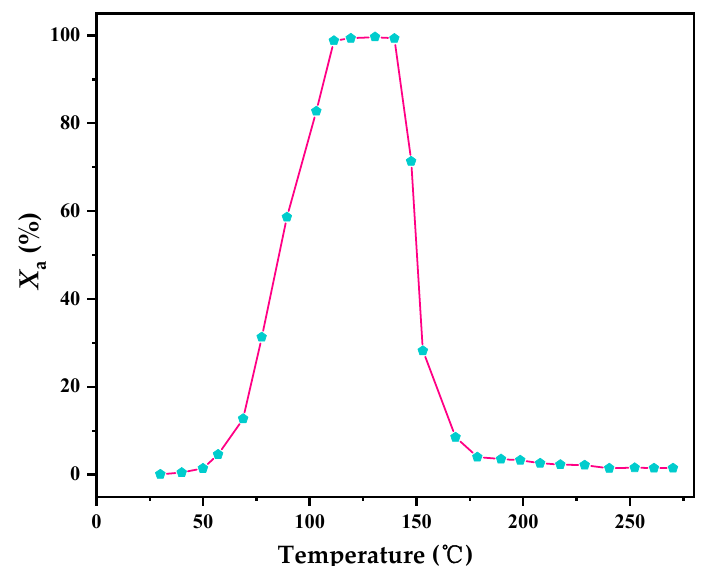
Figure 1. Plots of anisole removal ratios ( X a ) vs. temperature ( T ).